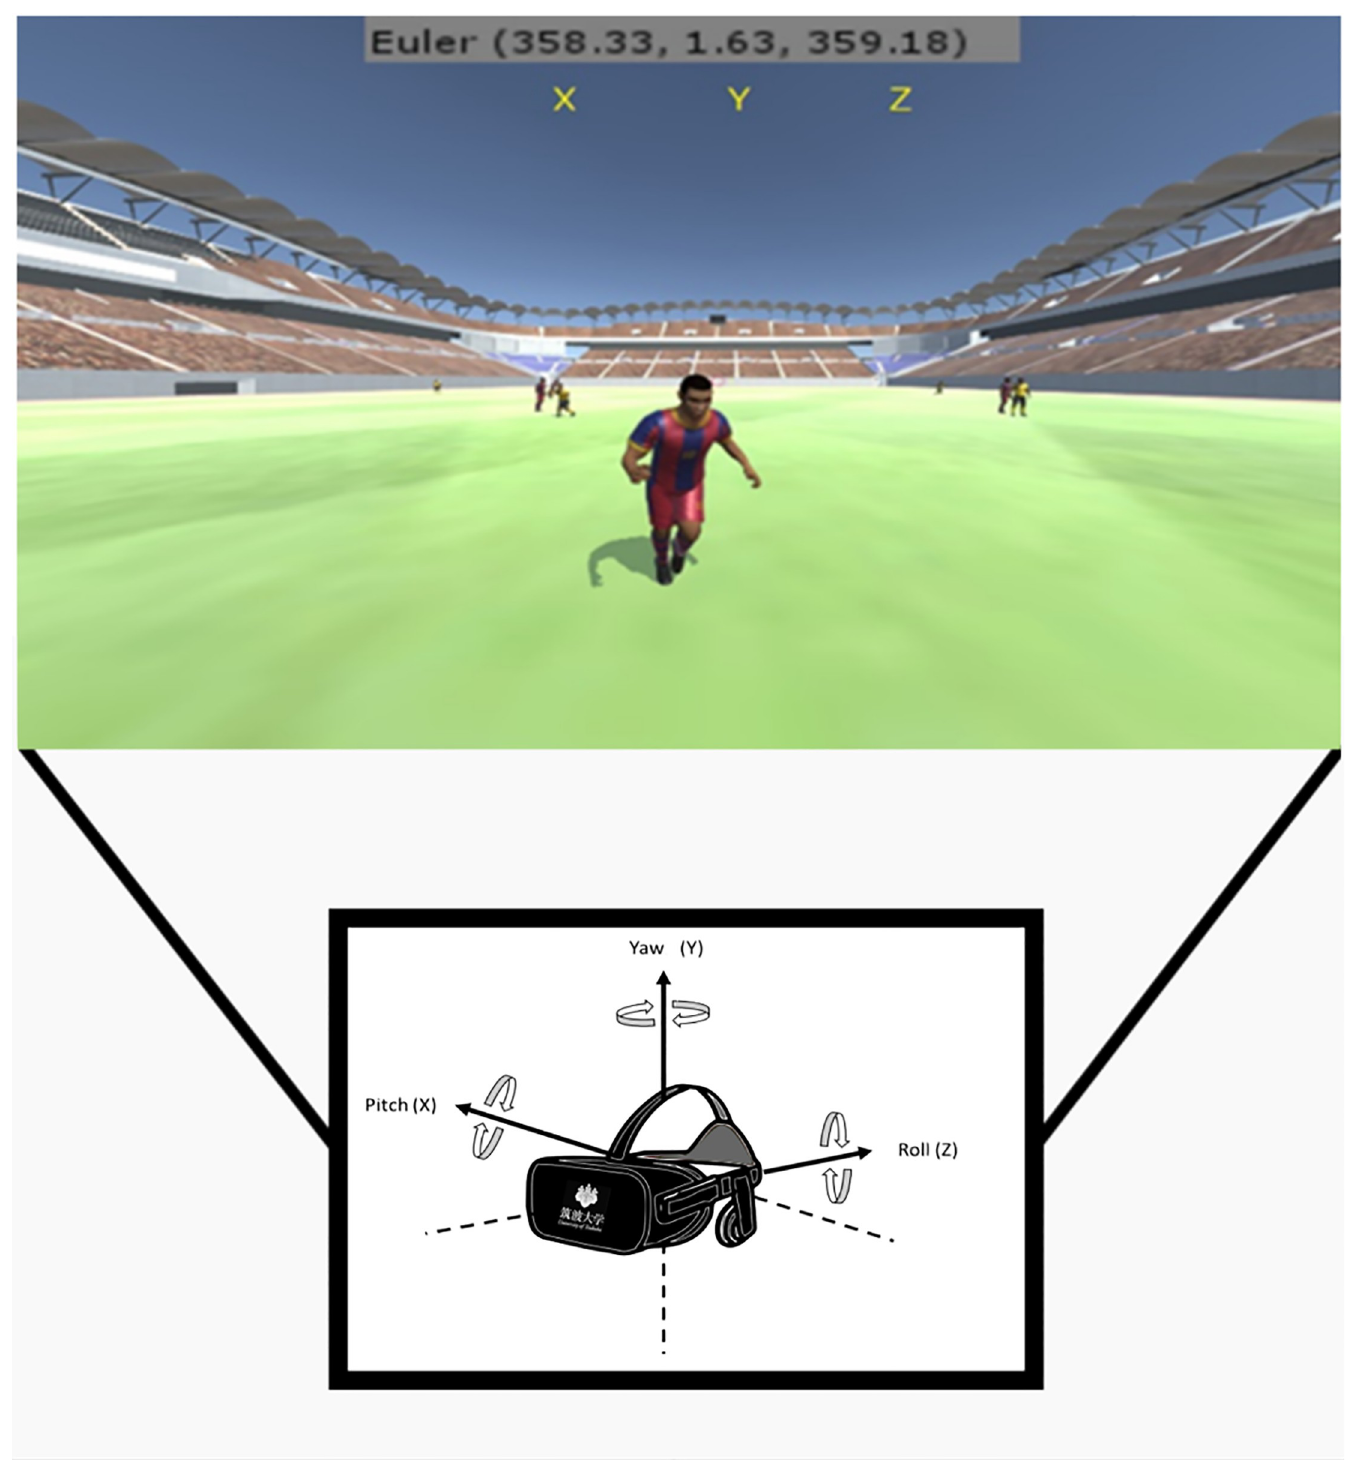
Fig 2. Yaw, pitch, roll, and Euler angles obtained from HMD.